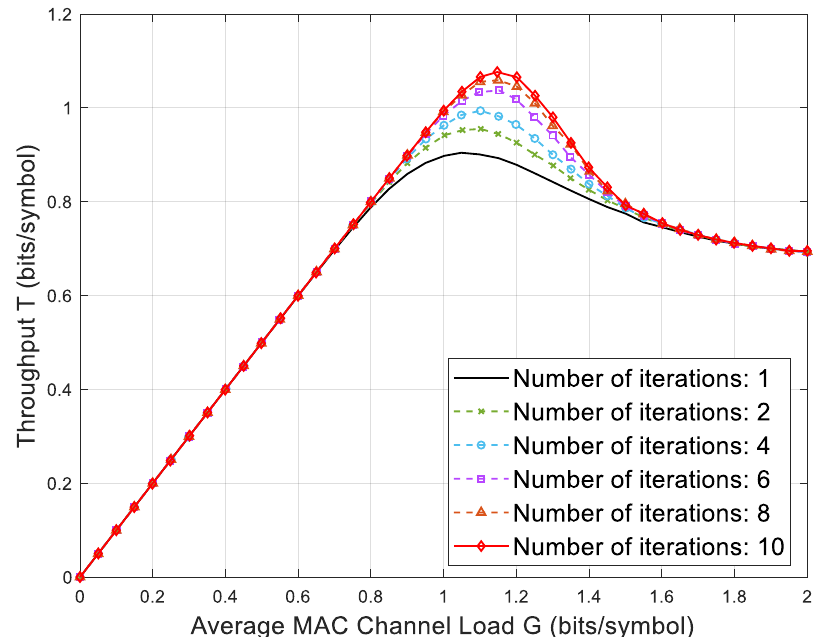
Figure 9. Throughput performance in relation to the number of iterations.